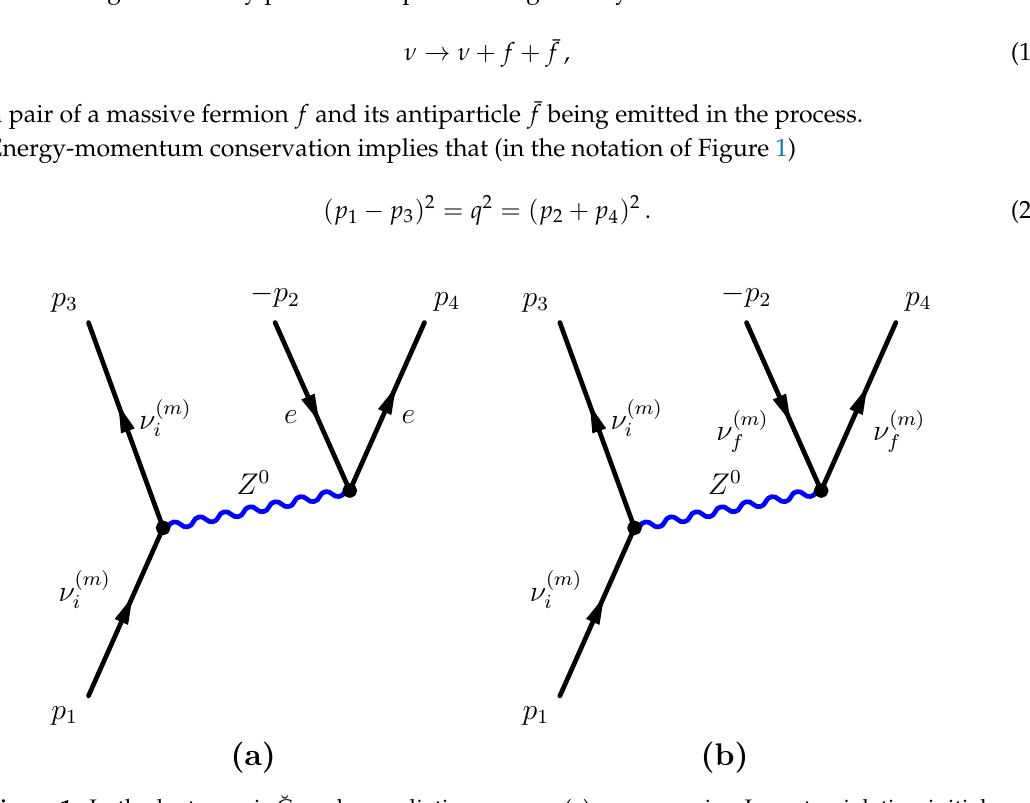
Figure 1. In the lepton-pair ˘Cerenkov radiation process ( a ), an oncoming Lorentz-violating initial ( m ) neutrino mass eigenstate ν decays, under emission of a virtual Z 0 boson, into an electron-positron i pair. The sum of the outgoing pair momenta is p 2 + p 4 ; one observes an inverted direction of the fermionic antiparticle line. The arrow of time is from bottom to top. The (blue) bosonic line carries the four-momentum q . Diagram ( b ) describes the neutrino-pair ˘Cerenkov radiation process, with a final ( m ) neutrino mass eigenstate ν f